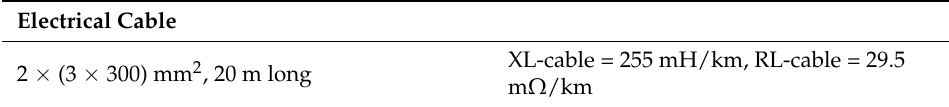
Table 6. Catalogue rating values of the industrial site cable.